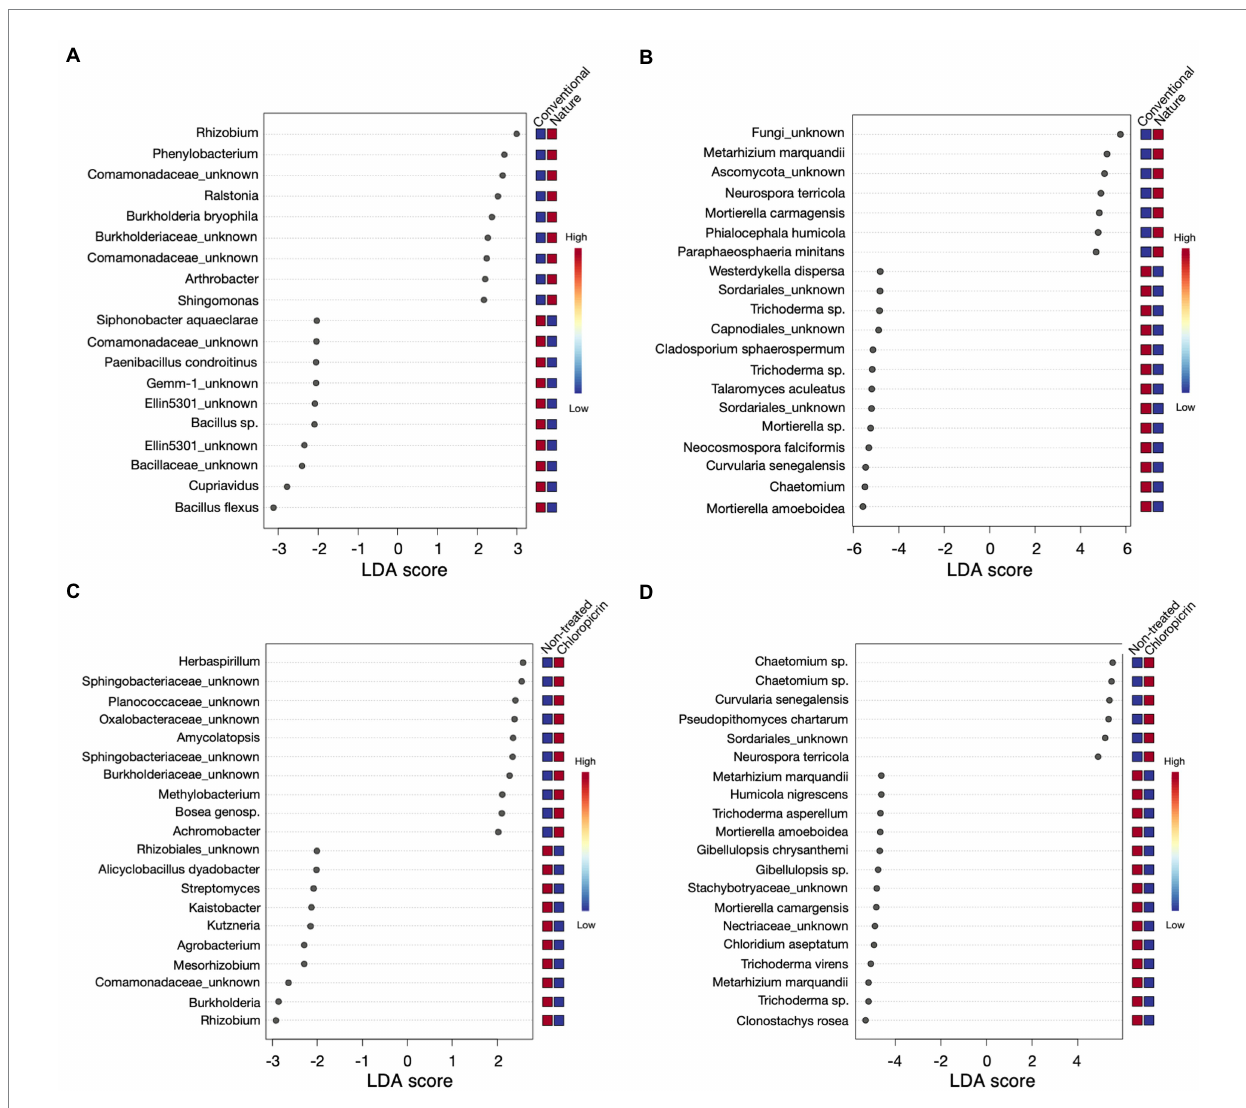
FIGURE 4 Linear discriminant analysis effect size (LEfSe) results of top 20 bacteria (A) and fungi (B) that were significantly enriched in either conventional or nature farming soil, and bacteria (C) and fungi (D) with significant abundance in either non-treated or chloropicrin-treated soils. Red boxes show a high abundance and blue boxes show a low abundance of a particular